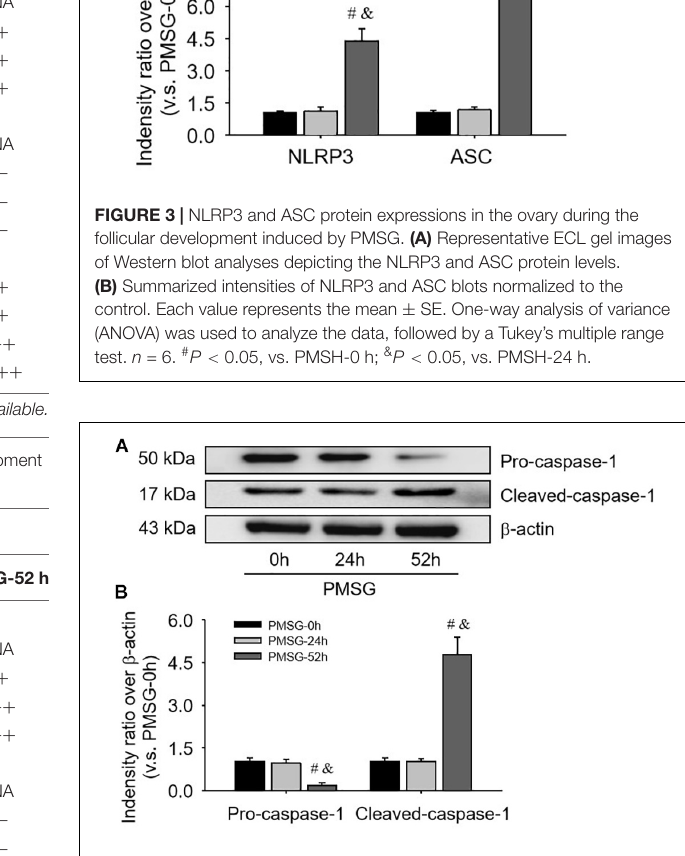
ovary during the follicular development induced by PMSG. (A) Representative